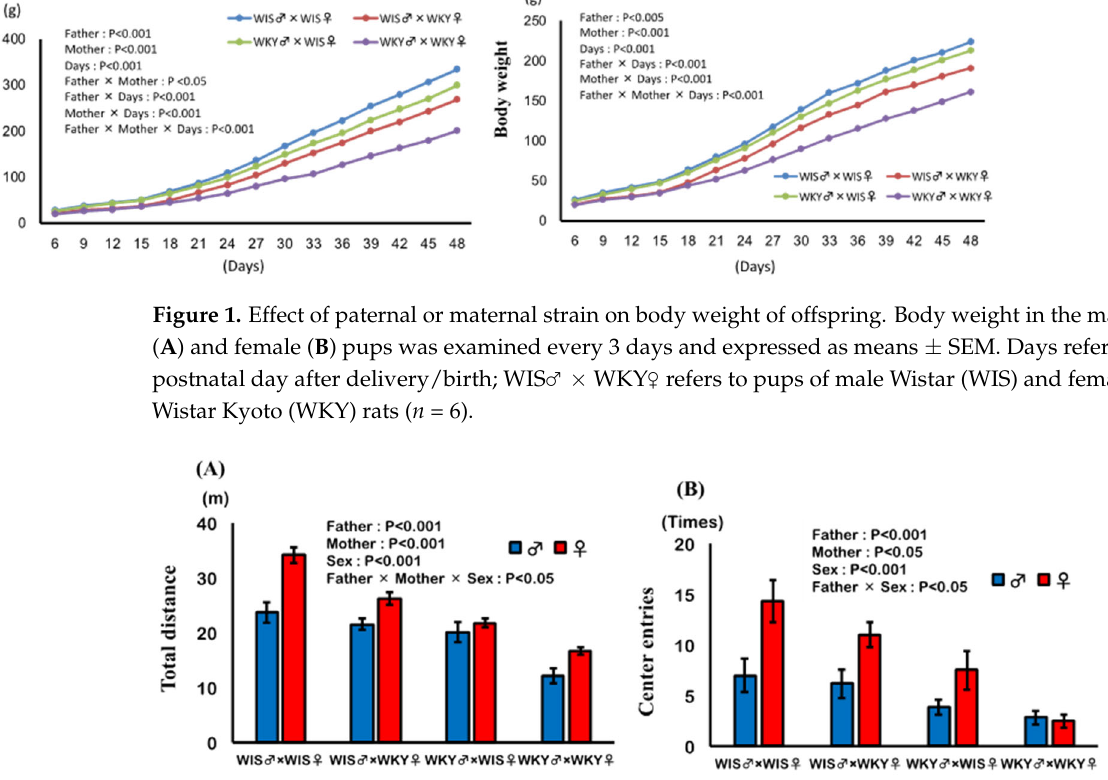
Figure 2. Effect of paternal or maternal strain and sex of pups on results of open field test. Total distance ( A ) and the number of entries to the central area ( B ) were analyzed and expressed as mean ± SEM. Here, NS = not significant. Pups were 56–57 days old; WIS ♂ × WKY ♀ refers to pups of male Wistar (WIS) and female Wistar Kyoto (WKY) rats ( n = 5–6).